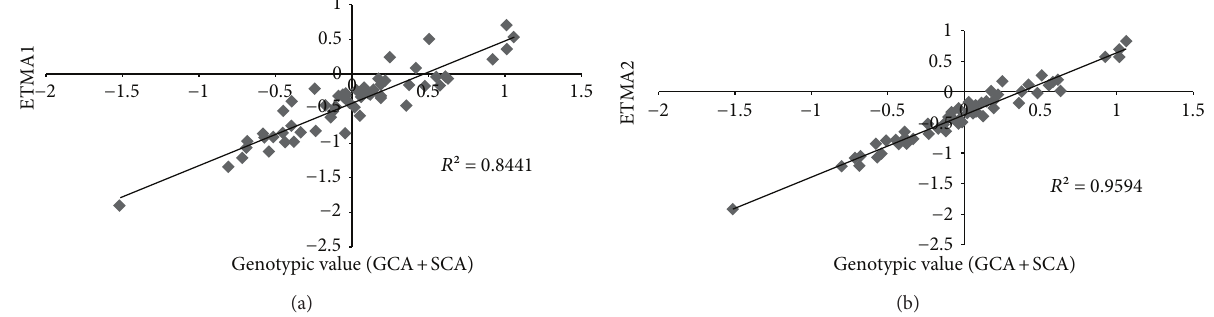
Figure 2: Total effects of the associated markers (TEAM) method when considering only the additive effect of markers (TEAM1) and the additive effects + the dominance effects